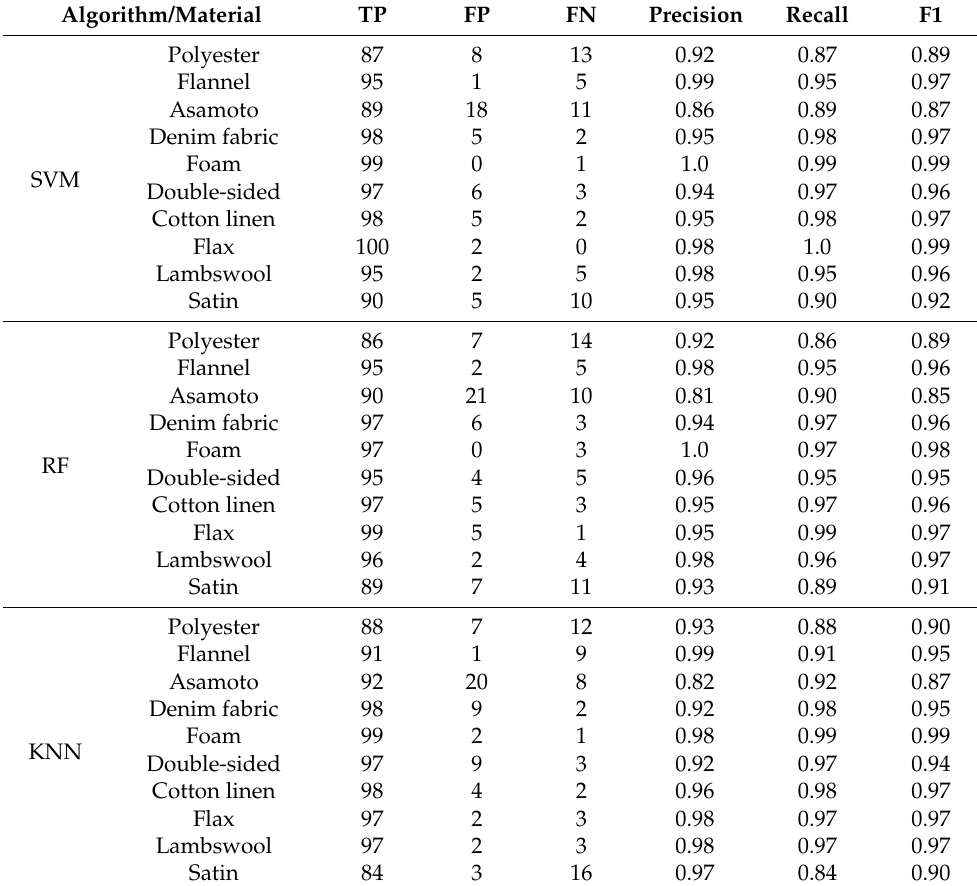
Table 2. Detection results of different materials using machine learning